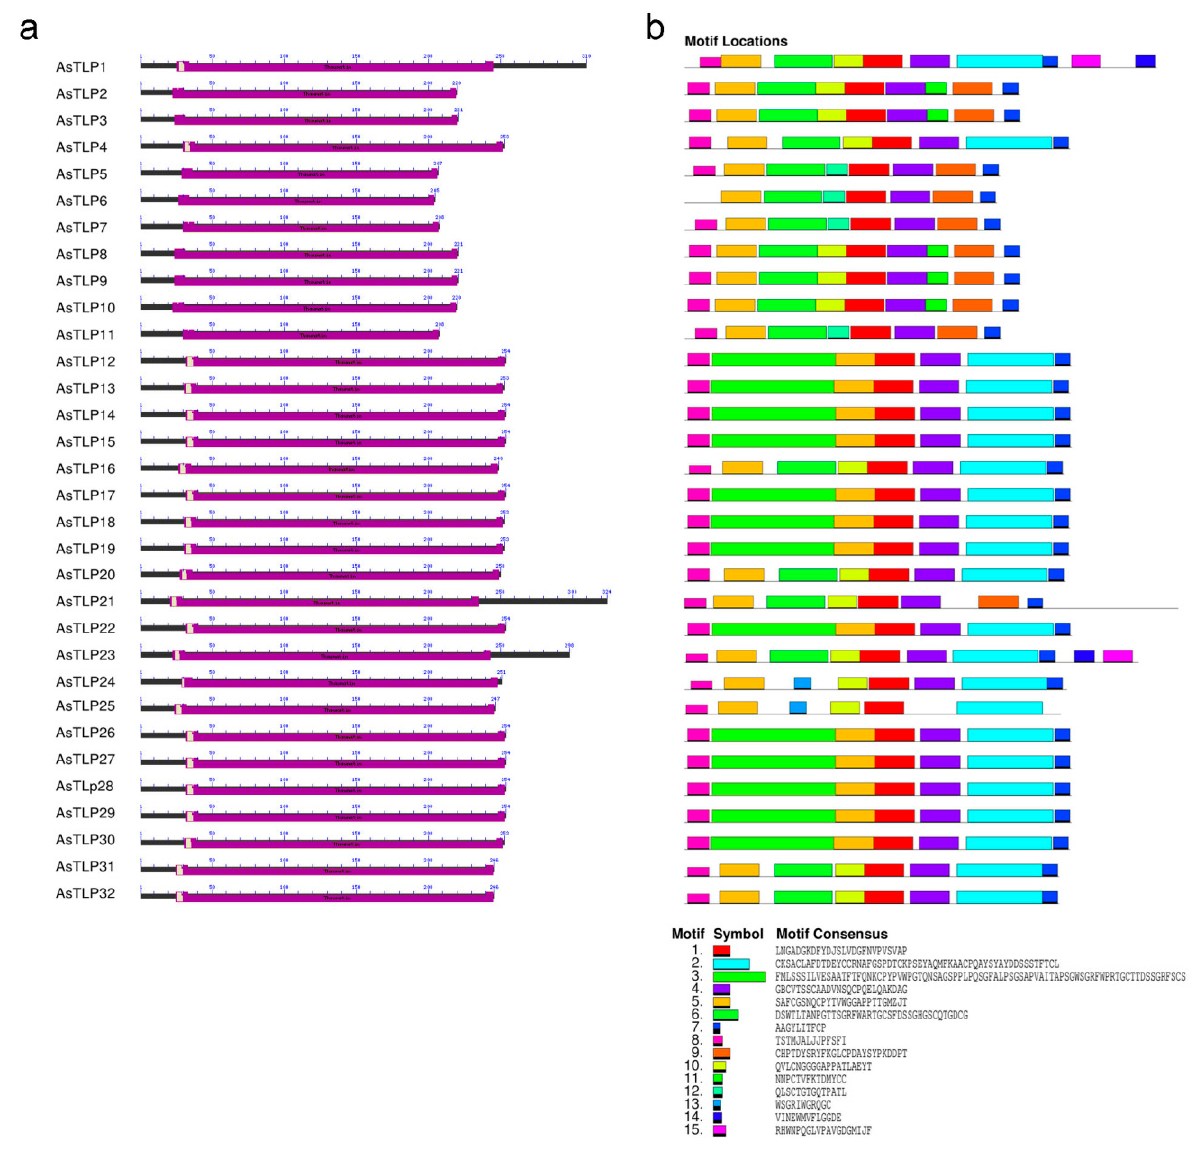
Figure 3. Position of the thaumatin domain (violet box) ( a ) and distribution of conserved motifs ( b ) in AsTLPs. Analysis was performed using MEME 5.3.0. The length of each box corresponds to that of the motif.